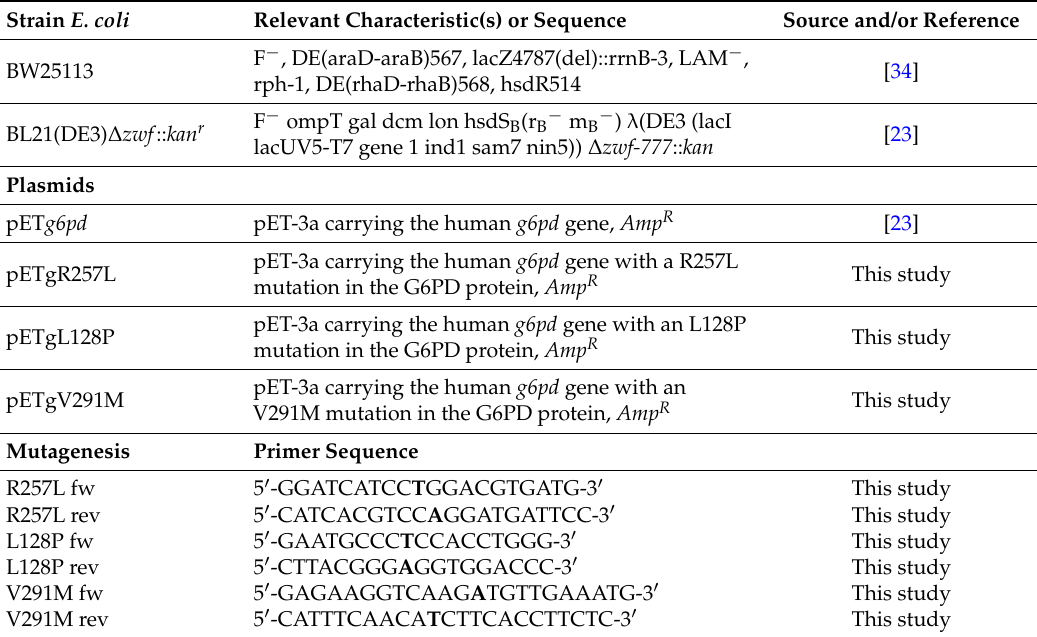
Table 3. Strains, plasmids, and primers used in this